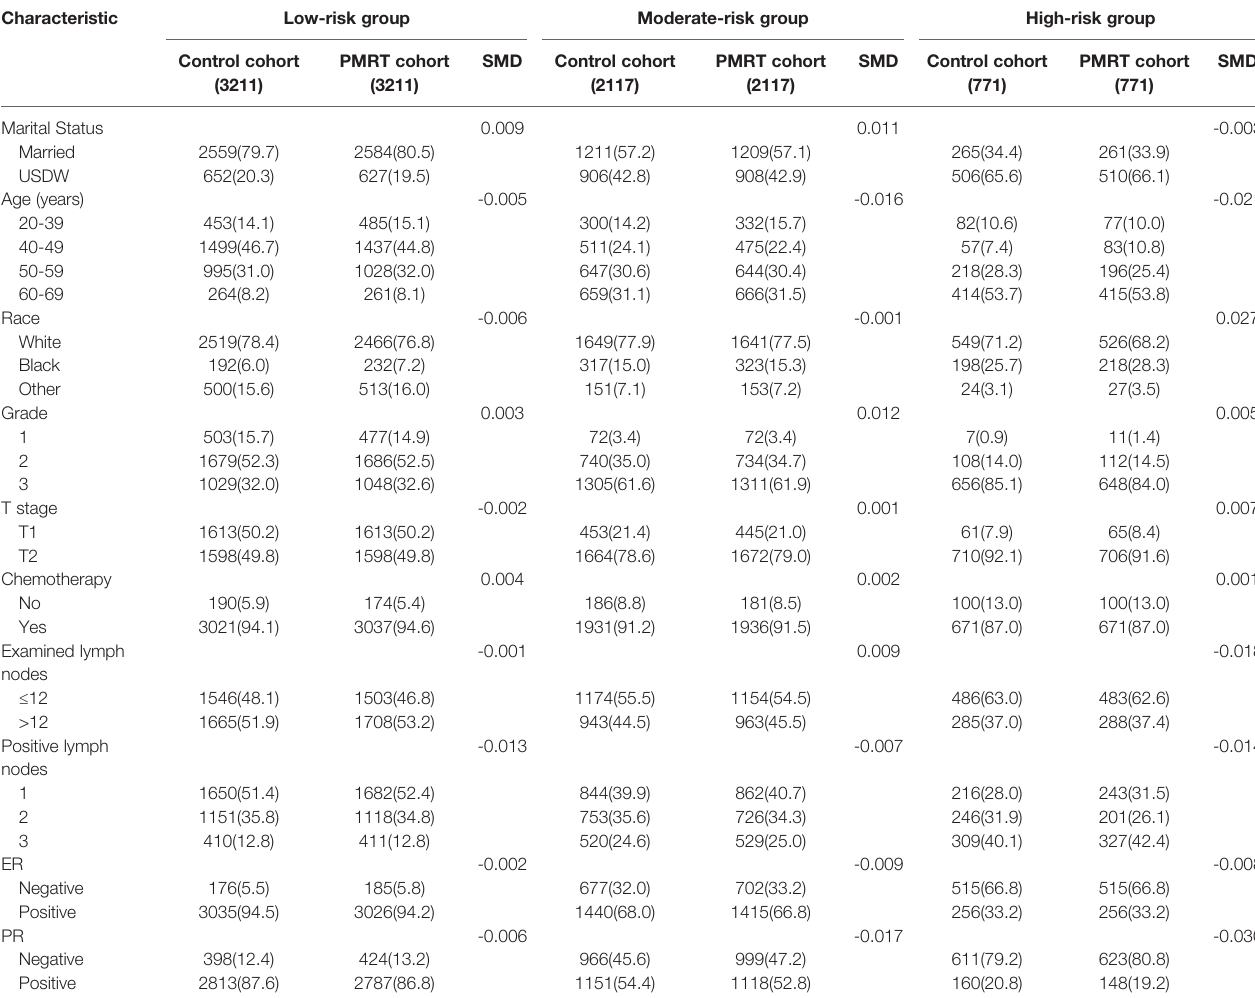
TABLE 3 | The baseline characteristics of the patients with PMRT or observation in each risk group based on the PSM.